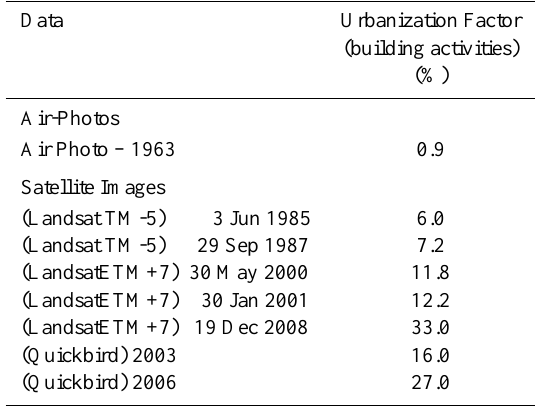
Table 1. Determined urbanization factors for each